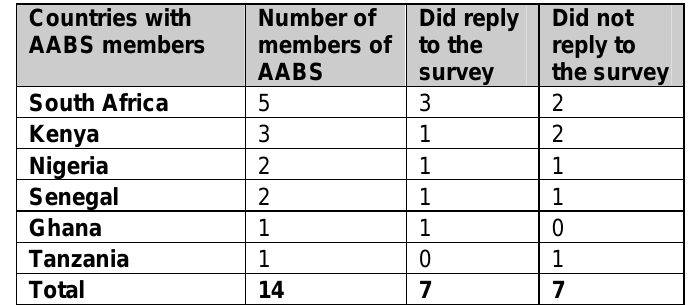
Table 3: Survey responses by AABS member countries